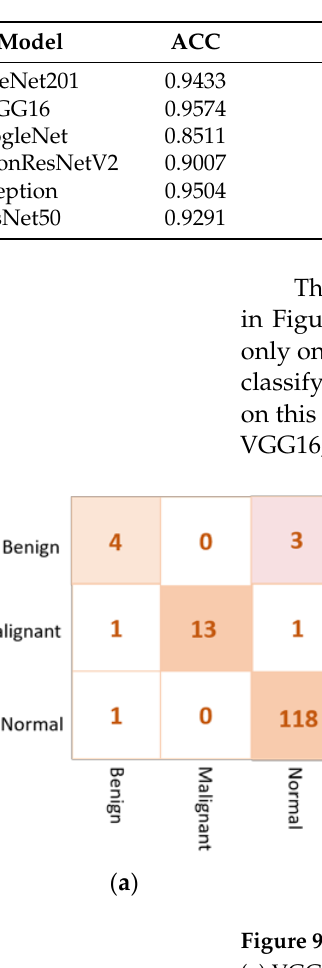
Table 6. Approach B multi-classification evaluation results of the individual pre-trained deep learning models using the testing set of the INbreast dataset.